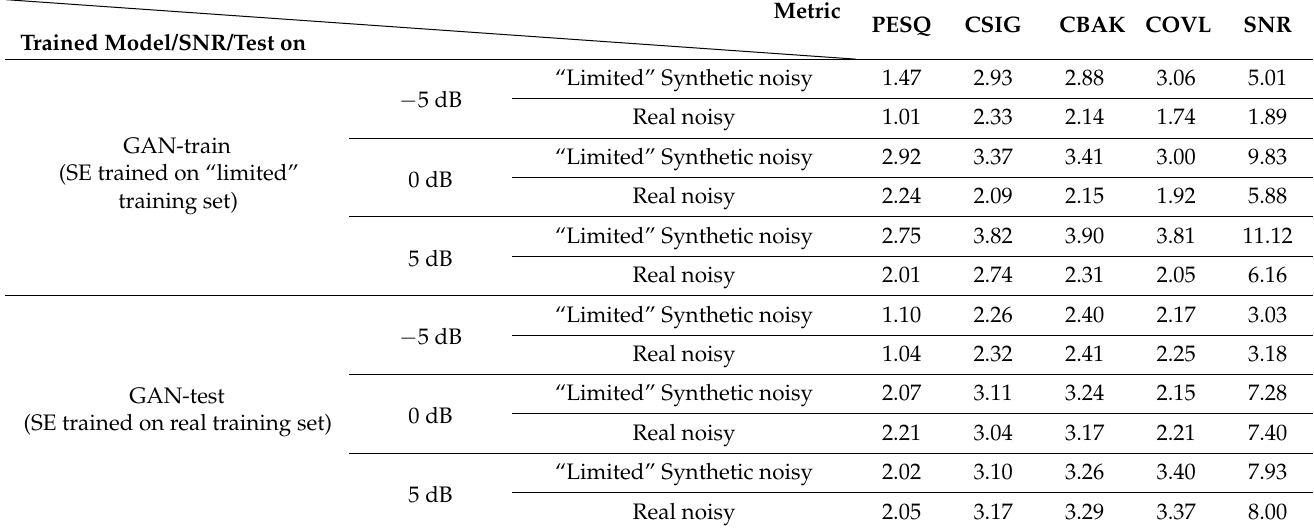
Table 2. Evaluation results for the second group of “GAN-train” and “GAN-test” experiments.